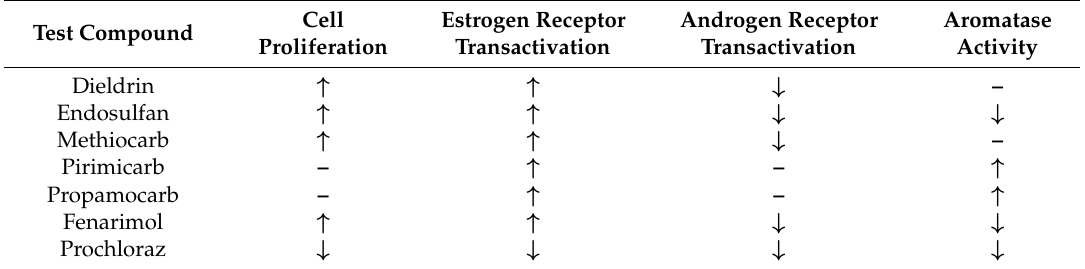
Table 1. Mechanisms of sex hormone function disturbance by pesticides (modified from [11]). Cell Estrogen Receptor Androgen Receptor Test Compound Proliferation Transactivation Transactivation